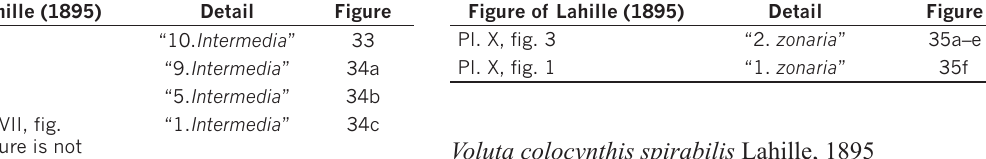
Table 13. Specimens of Voluta colocynthis lactea figured by Lahille (1895), with the detail of the inscriptions on their shells and figures